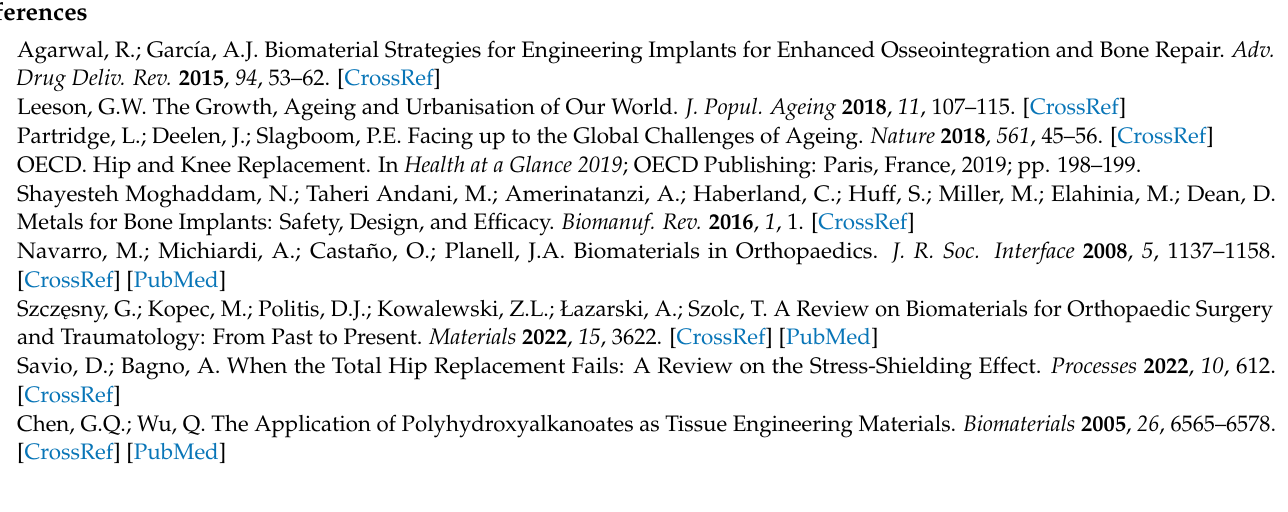
mer; Figure S2: Representative photographs of dog-bone specimens of (a) PHB, (b) PHB/PEG, (c) PHB/PEG/0.5%NFC, and (d) PHB/PEG/1%NFC; Figure S3: FESEM micrograph (secondary electrons) of the neat-PHB cross-section. The inclusions detected in the higher-magnification inset can be attributed to cellular residues derived from biological PHB production; Figure S4: (a) Storage modulus (E’) and (b) dissipation factor (Tan δ ) with Tg values of PHB/PEG/COP/NFC composites. (c) Storage modulus (E’) and (d) dissipation factor (Tan δ ) with Tg values of PHB/PEG/NFC compos- ites; Figure S5: Thermogravimetric analysis curves of (a) TGA and (b) DTGA of PHB, PHB/PEG, and PHB/PEG/NFC composites. Thermogravimetric analysis curves of (c) TGA and (d) DTGA of PHB, copolymer, PHB/PEG, and PHB/PEG/NFC/COP composites. TGA curves were recorded between 25 and 500 ◦ C. DTGA highlights the most significant weight loss between 200 and 450 ◦ C; Table S1: Tensile and flexural mechanical properties of the prepared materials expressed as mean value and related standard